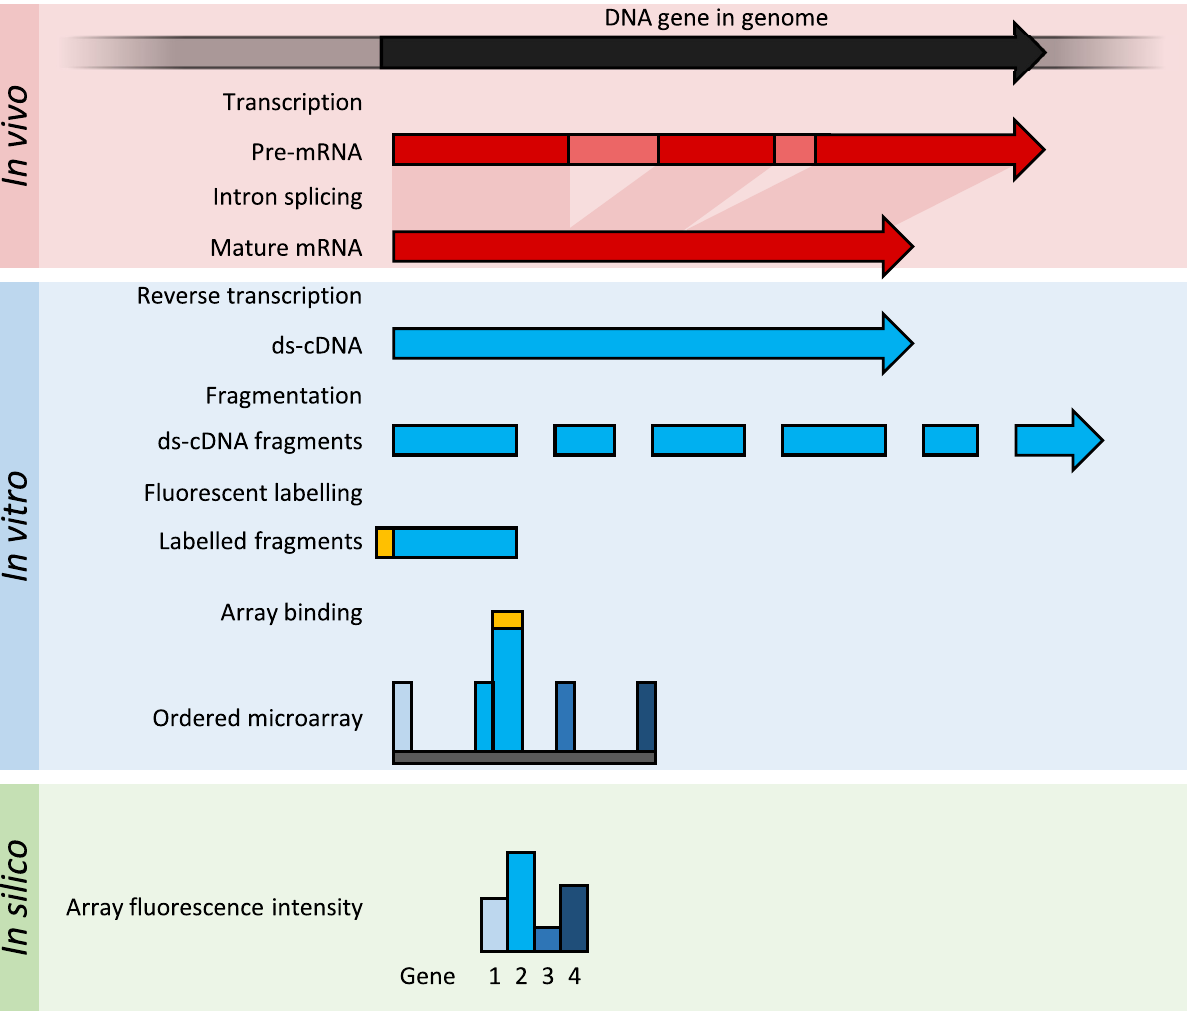
Fig 3. Summaryof DNA microarrays. Within the organisms, genes are transcribed and spliced (in eukaryotes) to producemature mRNA transcripts (red). The mRNA is extracted from the organismand reverse transcriptase is used to copy the mRNA into stable double- stranded–cDNA (ds-cDNA; blue). In microarrays, the ds-cDNA is fragmented and fluorescently labelled(orange).The labelledfragments bind to an orderedarray of complementary oligonucleotides, and measurement of fluorescent intensity across the array indicatesthe abundanceof a predetermined set of sequences.These sequencesare typically specificallychosen to report on genes of interest within the organism’sgenome.